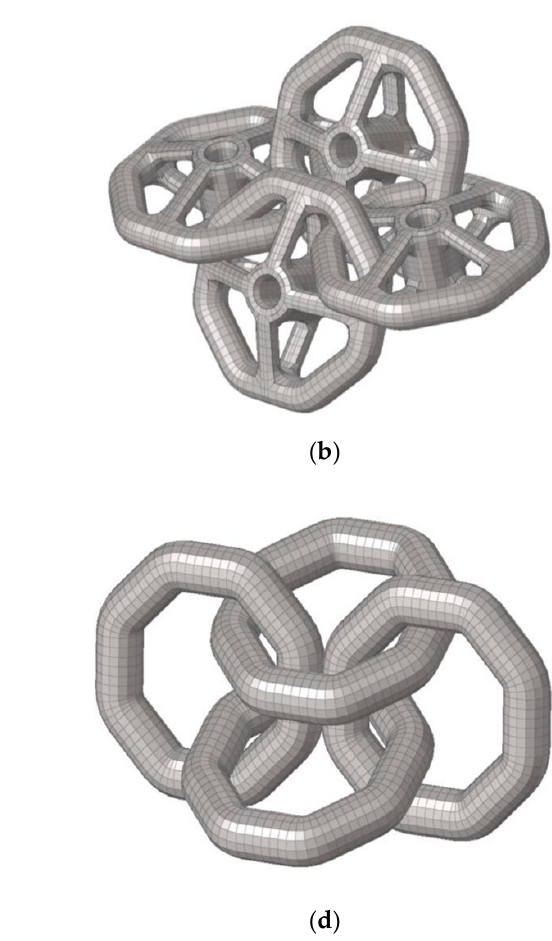
Figure 12. Discretization of the 3D printed structures made of Ti ‐ 6Al ‐ 4V titanium alloy: ( a ) structure S1; ( b ) structure S4; ( c ) structure S2 and ( d ) structure S3.